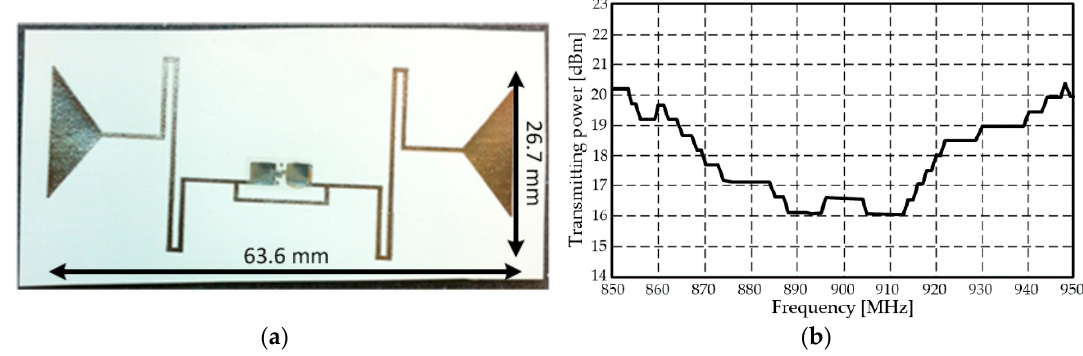
Figure 10. ( a ) Inkjet-printed radio frequency identification (RFID) tag on synthetic Teslin paper and ( b ) transmitted (Tx) power from the reader required to read the inkjet-printed RFID tag.